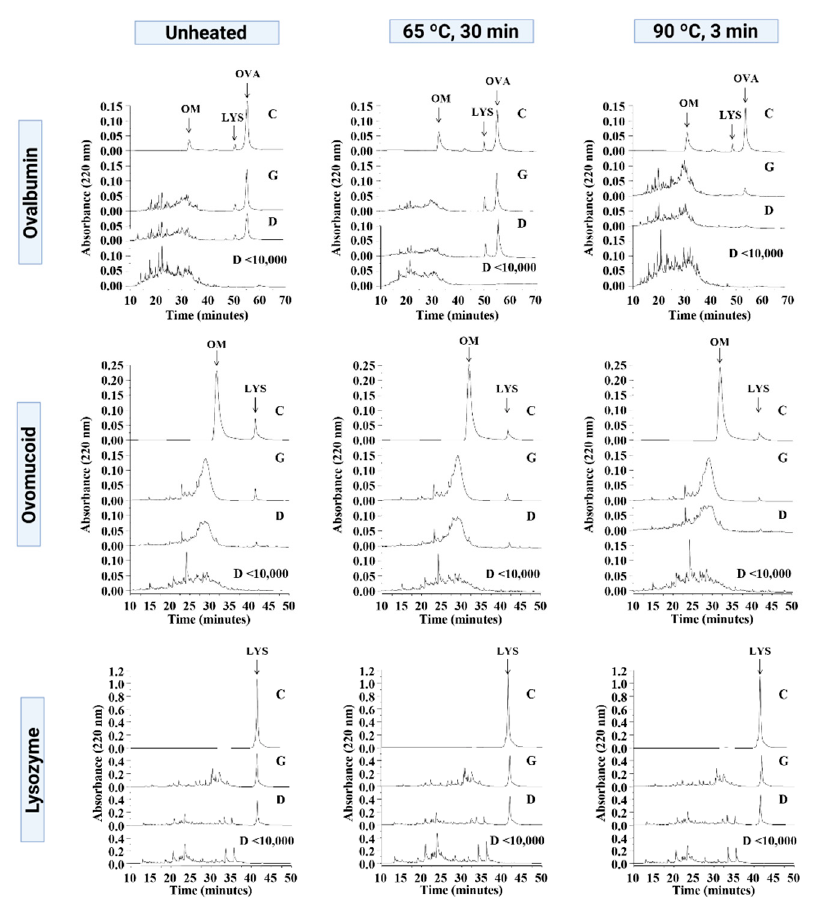
Figure 2. RP-HPLC chromatograms of undigested proteins (C), gastric digests (G), and gastroduodenal digests (D), including the fraction less than 10 kDa (D < 10,000), of ovalbumin (OVA), ovomucoid (OM), and lysozyme (LYS) subjected to two different heat treatments, 65 °C for 30 min and 90 °C for 3 min.